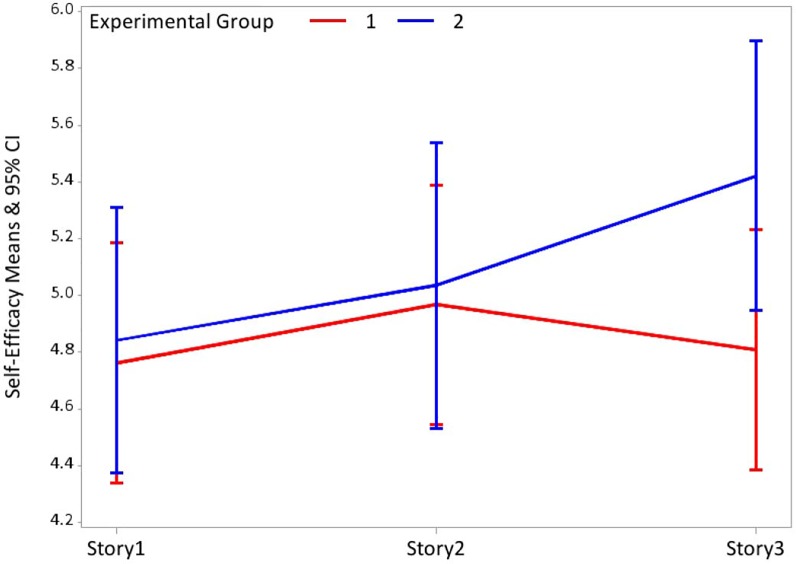
Participants' development in self-efficacy between the different stories.